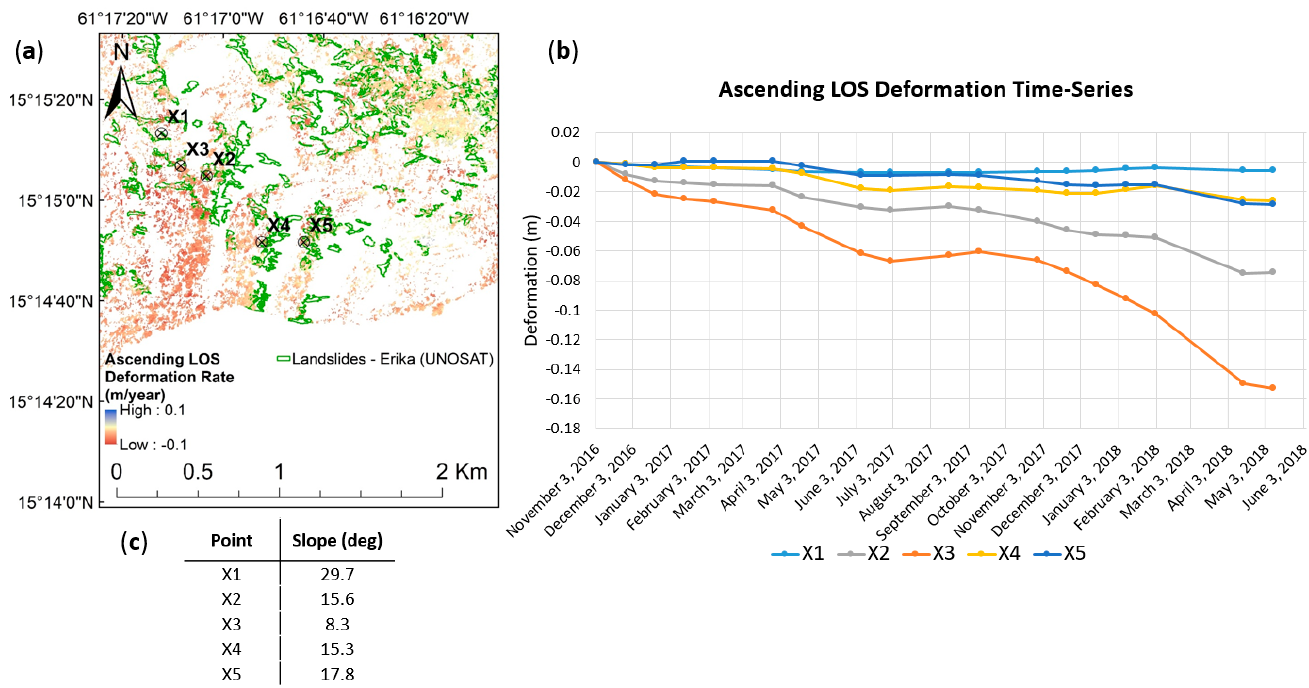
Figure 6. ( a ) Landslides triggered by Tropical Storm Erika [42] integrated with post-Tropical Storm Erika ascending LOS deformation-rate map. ( b ) is the deformation time-series of the points. Points X3 and X5 show active landslides after Tropical Storm Erika. ( c ) provides the slope details of points X1 to X5 highlighted in ( a ).